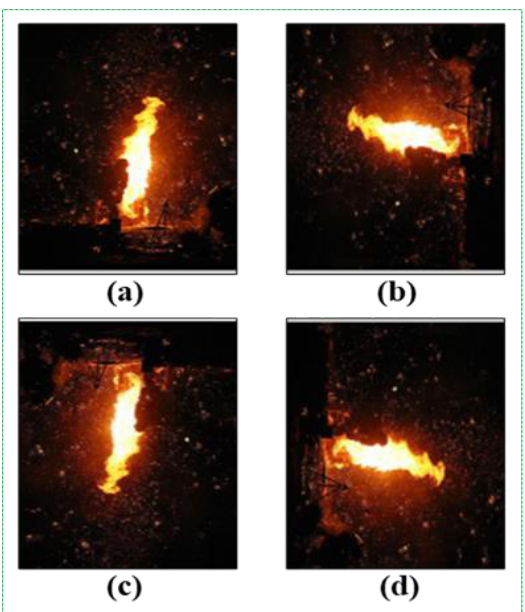
Figure 2. Original image ( a ); 90° rotation ( b ); 180° rotation ( c ); 270° rotation ( d ).